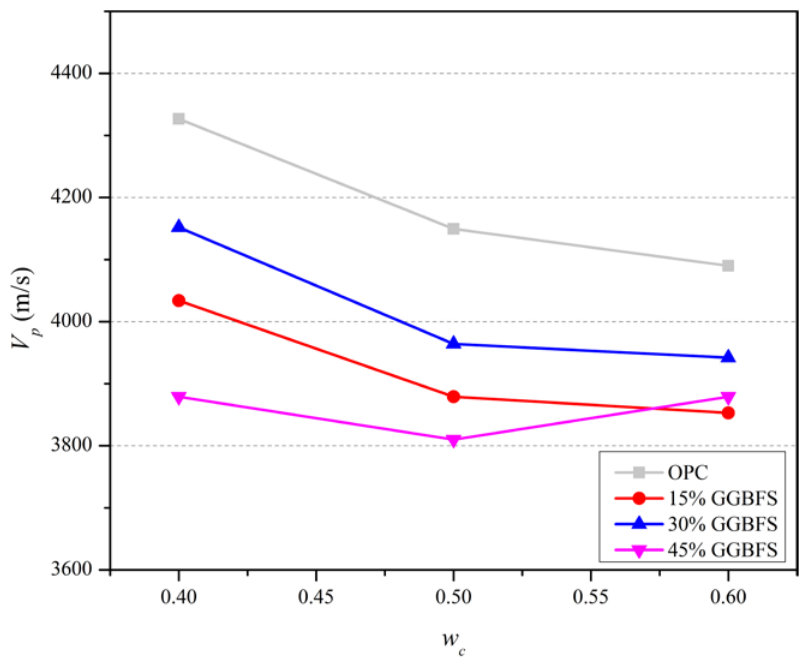
Figure 4. Mean value of V p at 28 days obtained by varying the amount of water content in slag blended mortar mixtures and OPC.